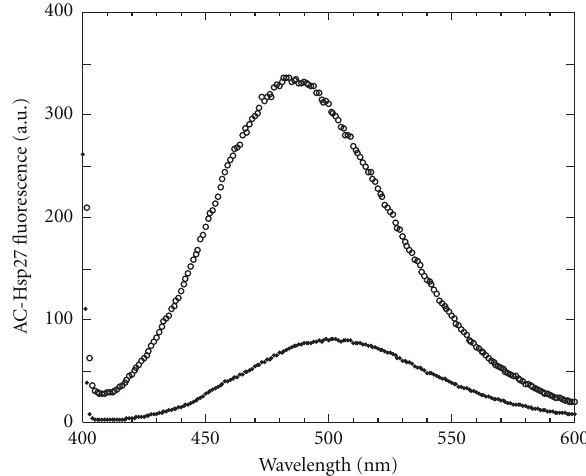
Figure 2: E ff ect of F-actin on the fluorescence spectrum of AC- Hsp27. AC-Hsp27 (1 μ M) at 37 ◦ C in F-bu ff er in the absence (closed circles) and presence (open circles) of 40 μ M F-actin after overnight incubation at 37 ◦ C.